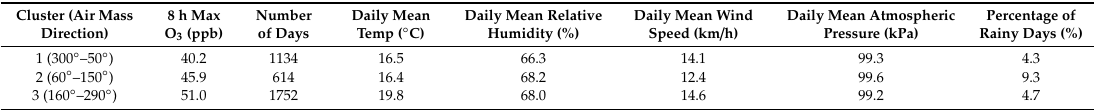
Table 3. Smog season meteorological parameters and 8 h max O 3 concentrations in Windsor during 1996–2015 in the three